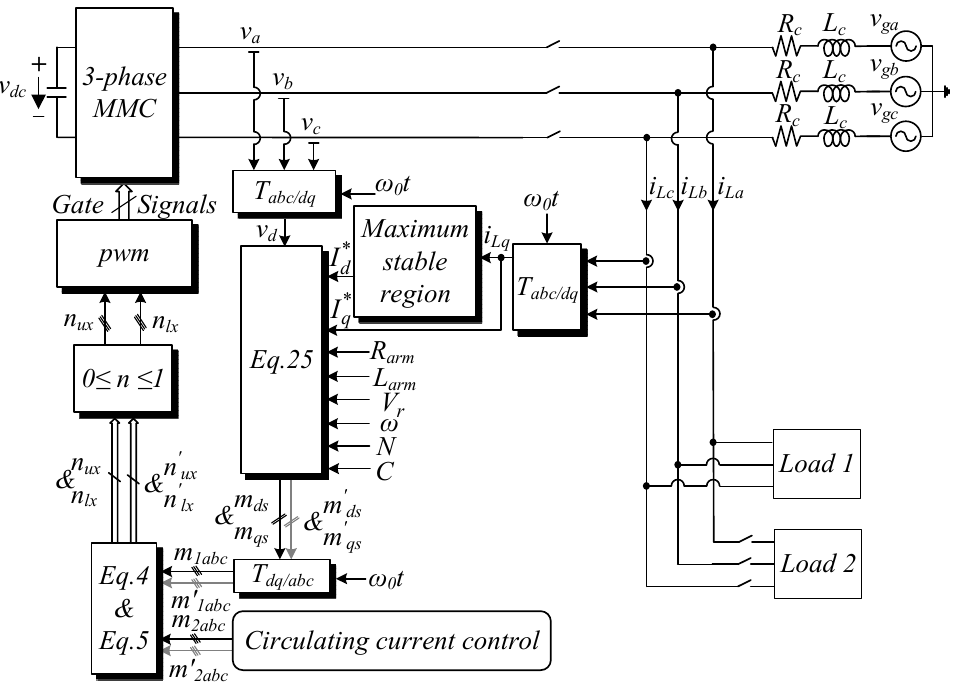
Figure 5. General configuration of the proposed MMC-based STATCOM controller.